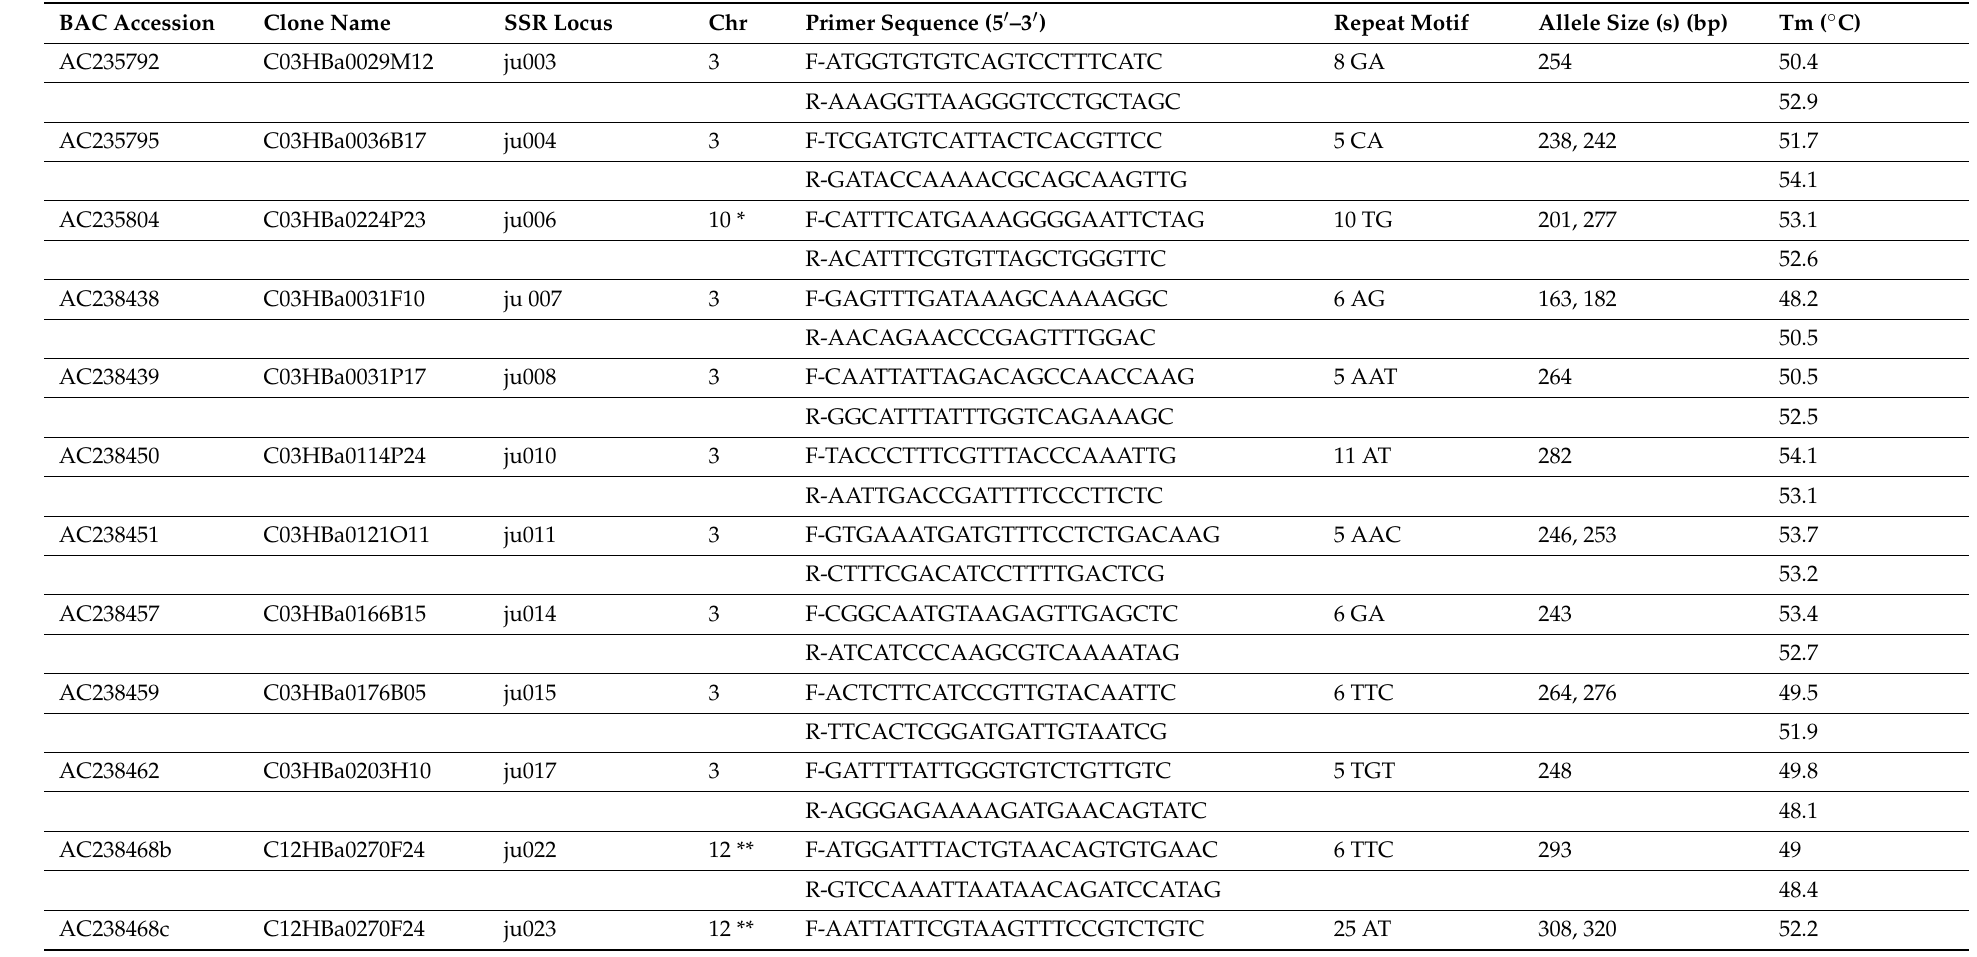
Table 2. The 20 novel microsatellite loci developed in the study along with their related PCR